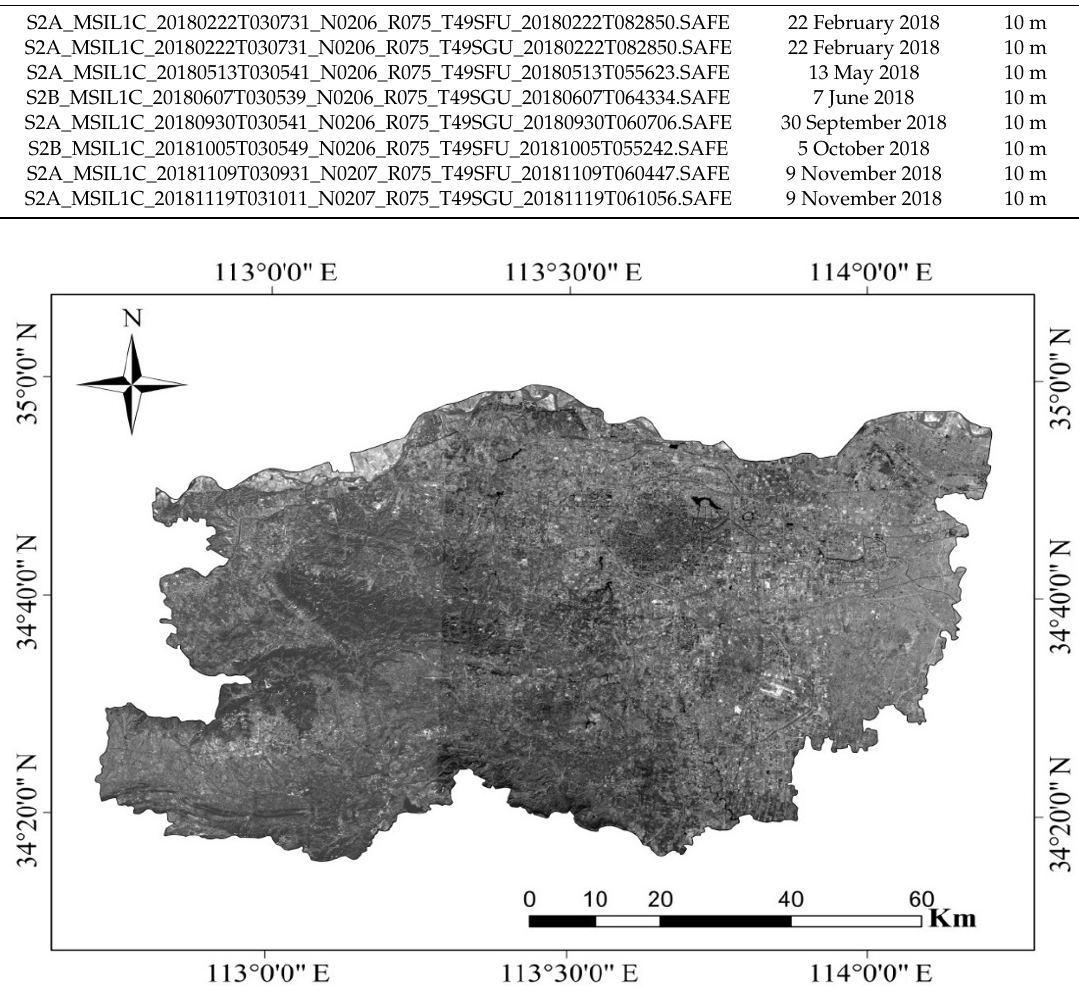
Figure 2. The Sentinel-2 image with scene coverage of the study area.